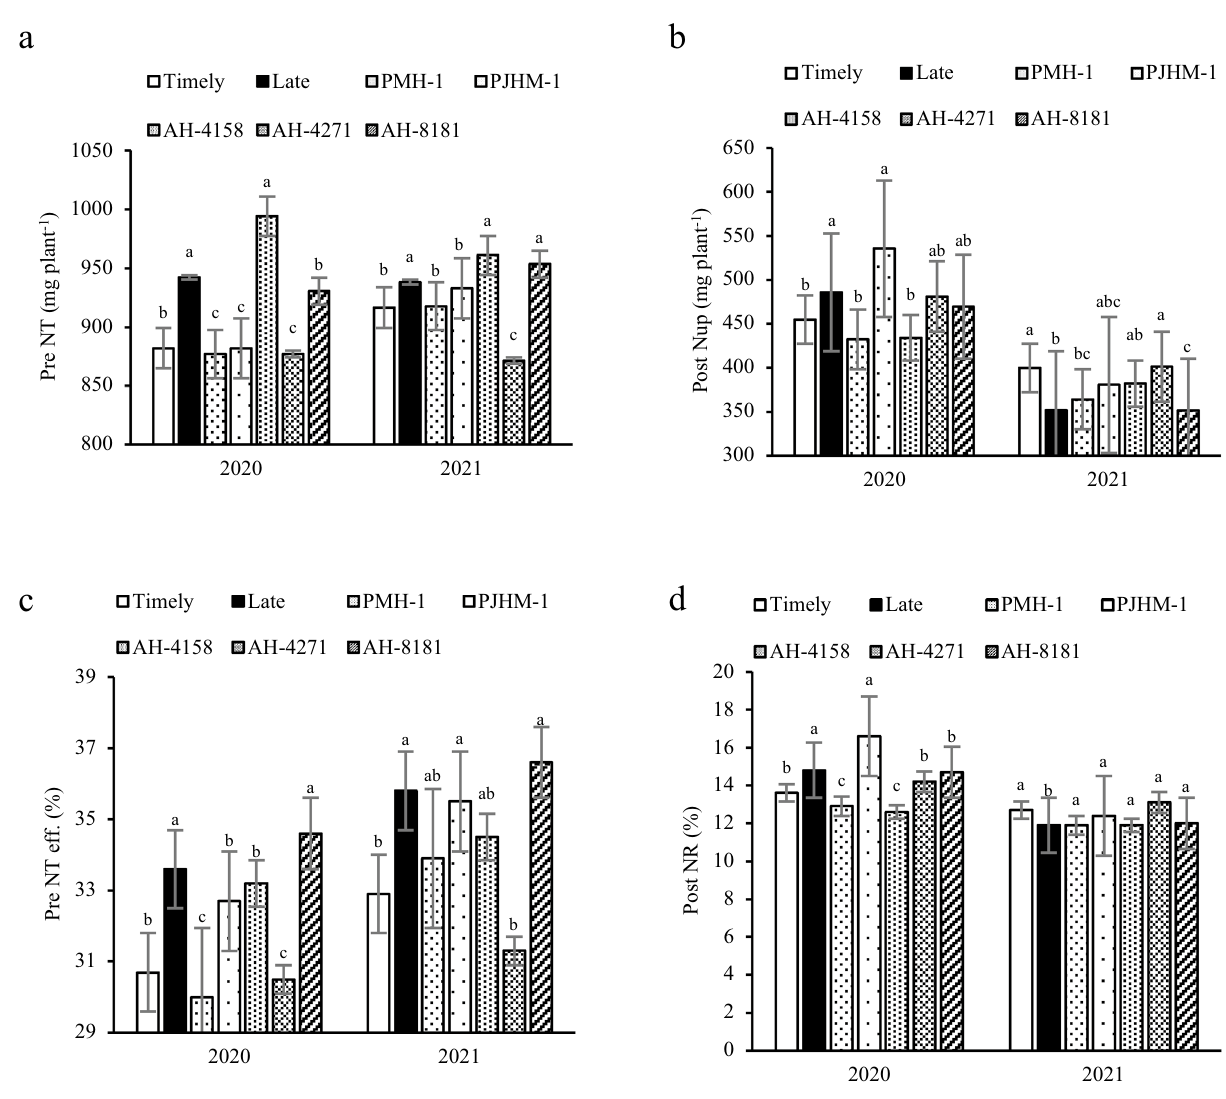
Figure 2. Pre NT- pre-anthesis Nitrogen translocation ( a ), Post NuP- post-anthesis Nitrogen uptake ( b ), Pre NT-eff.- pre-anthesis Nitrogen translocation efficiency ( c ), Post NR- ratio of post-anthesis N uptake to total N accumulation ( d ). Within years, sowing time, and genotypes, different letters on the individual bars of a figure indicate significant difference ( p ≤